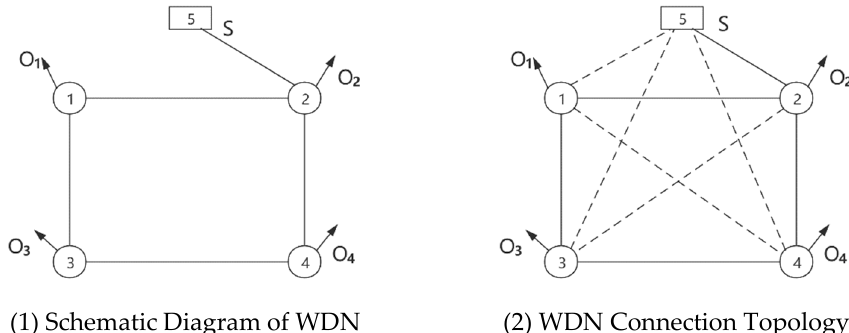
Figure 2. Topological diagram of flow pressure calculation in a water distribution network. Matrix A shown in Equation (12) represents the connection between two nodes. All values of the matrix consist of 1, 0 and − 1. Furthermore, 1 and − 1 represent the flow direction of the connected nodes, and 0 represents the absence of a connection between two nodes.